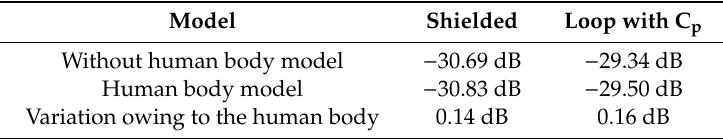
Table 2. Reflection coe ffi cients with and without simple cylindrical